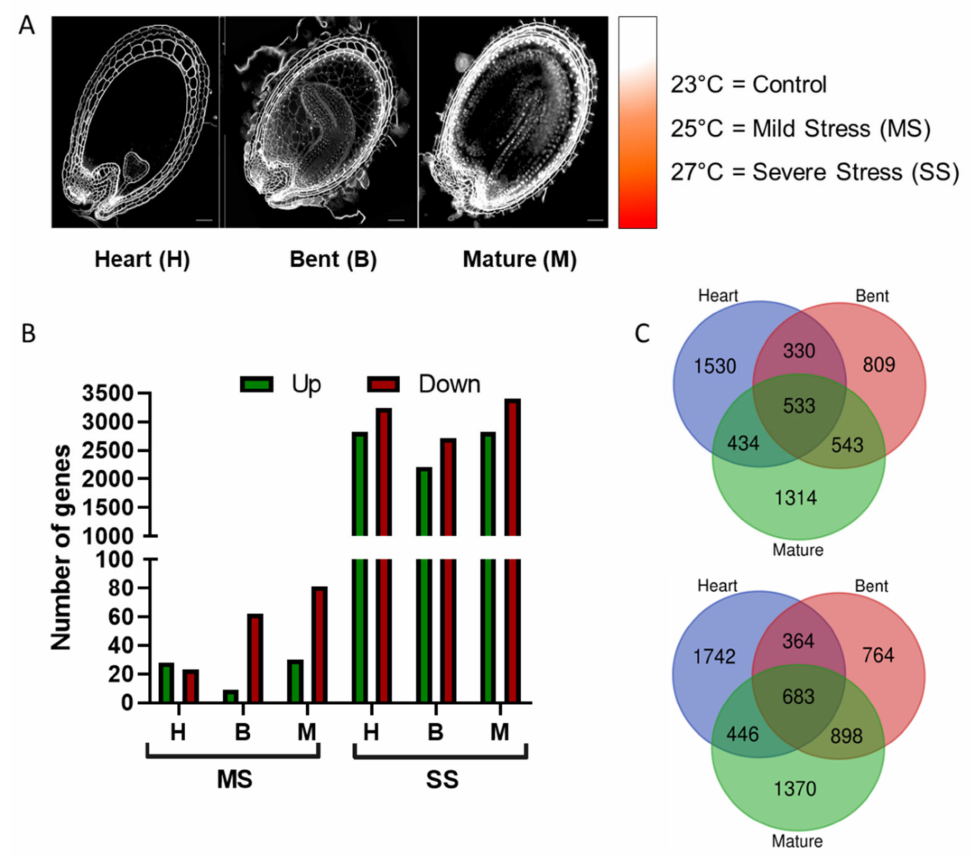
Figure 2. Transcriptomics analysis of Col-0 seeds developed under heat stress conditions. ( A ) RNA- Seq samples were obtained during embryo developmental stages showed here in time-course order: Heart (H), Bent ( B ), and Mature (M). Average temperature of 23 ◦ C was used as control against Mild Stress (MS) at 25 ◦ C and against Severe Stress (SS) at 27 ◦ C. ( B ) Scatter plot showing the quantity of differentially expressed genes (DEGs) for MS in orange and SS in red. ( C ) Venn diagrams of DEGs from SS at each embryo developmental stage. Upper panels show upregulated genes and lower panels show downregulated